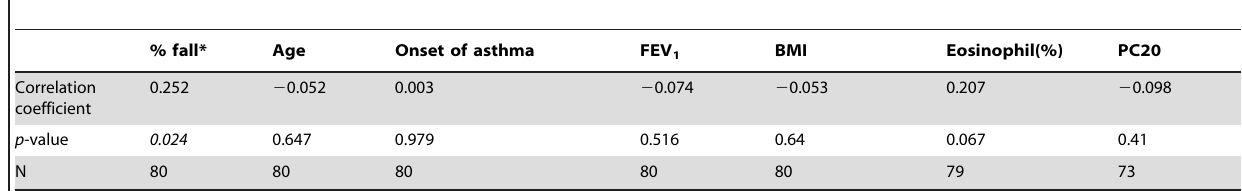
Table 3. Correlation of eosinophil-derived neurotoxin levels with other clinical variables.